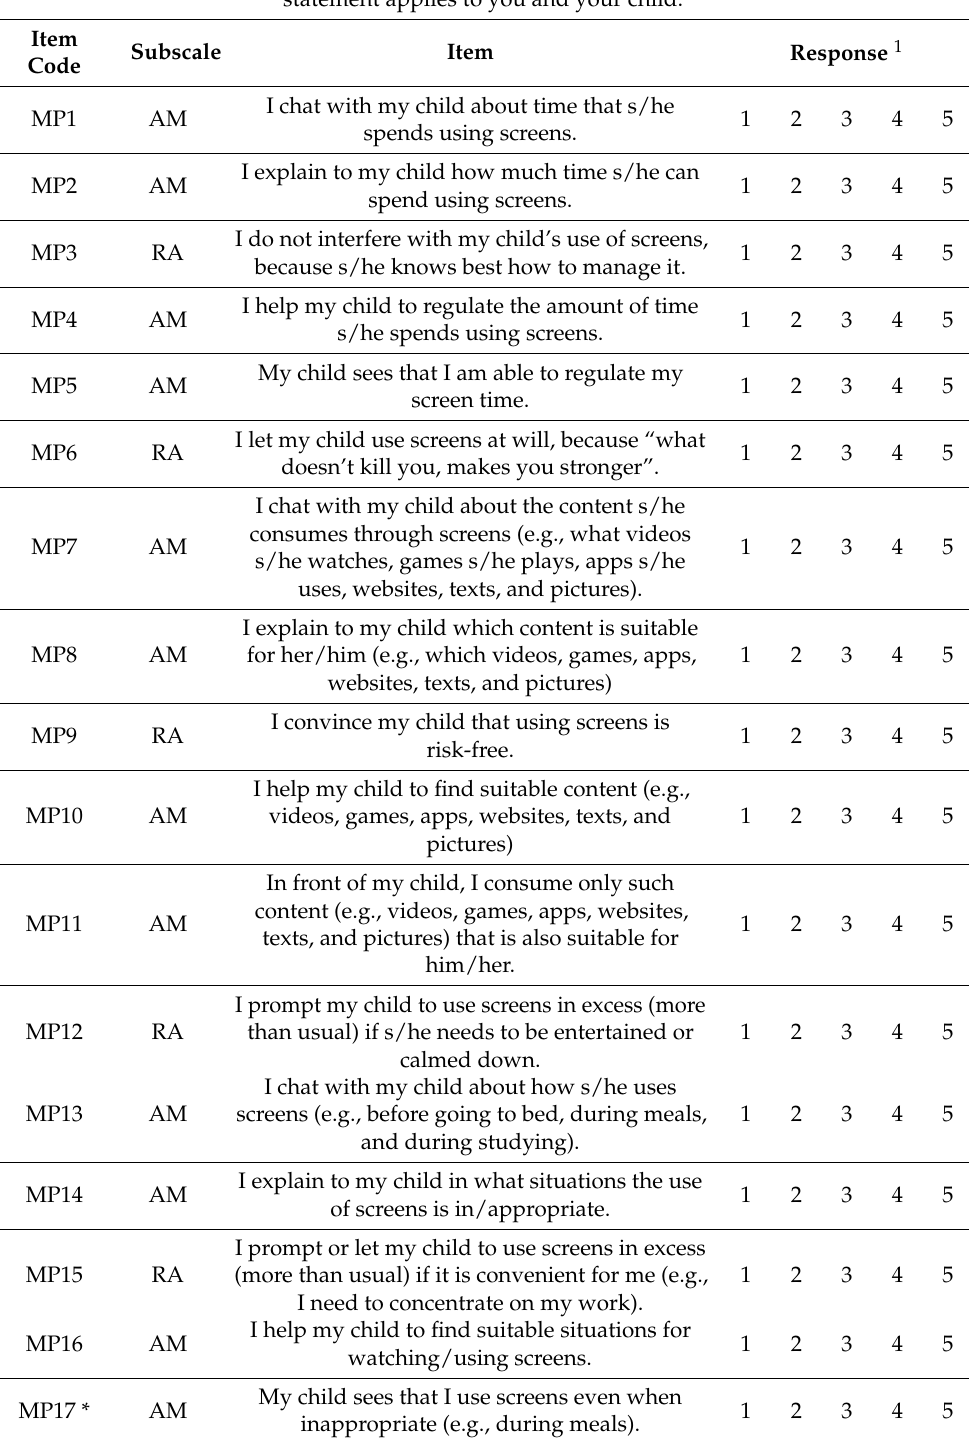
Table A1. MEPA-36: English